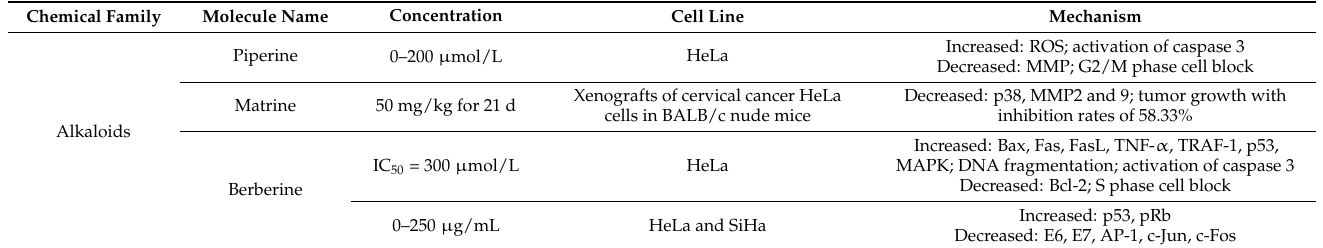
Figure 3. Chemical structure of several alkaloids in anti-cervical-cancer. Table 3. Effect of alkaloids on cervical cancer.